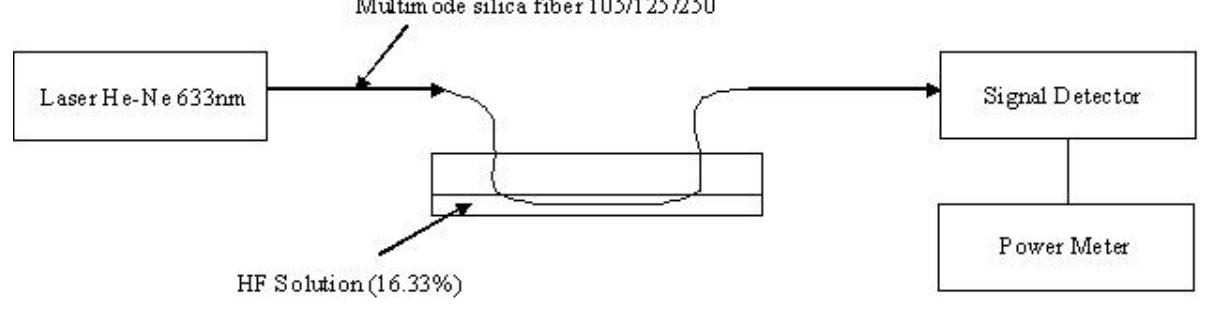
Figure 9. Schematic drawing of the fiber etching setup.